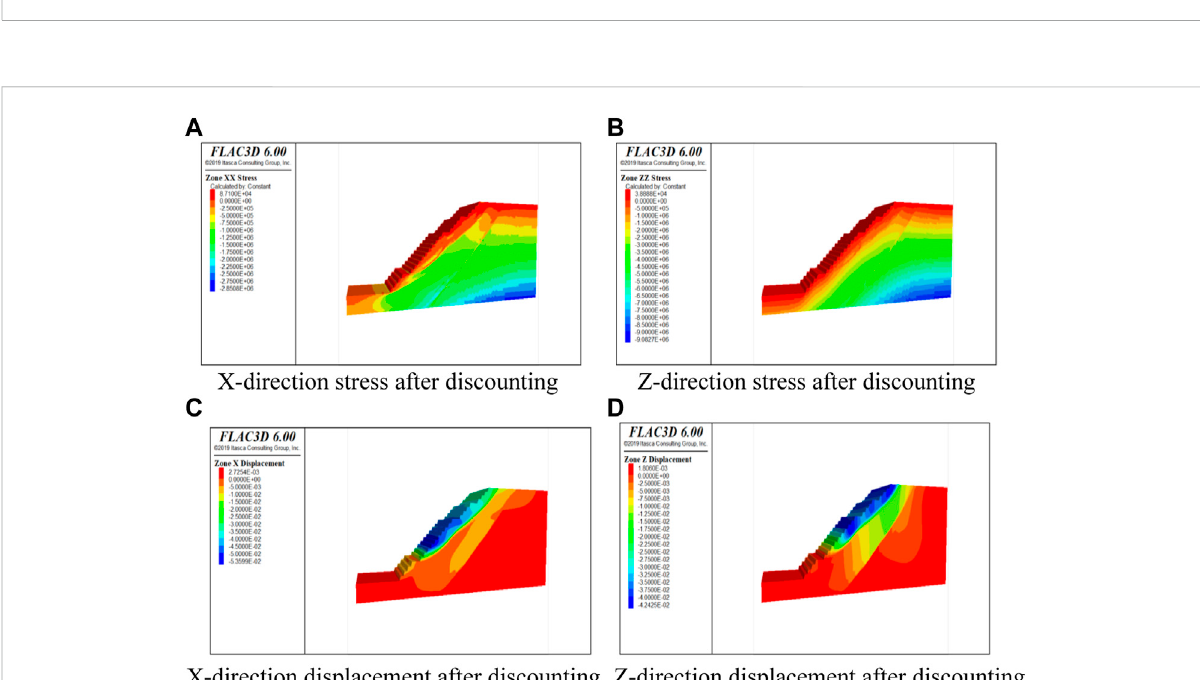
FIGURE 12 Stress and displacement clouds in x and z directions under self-weight conditions.